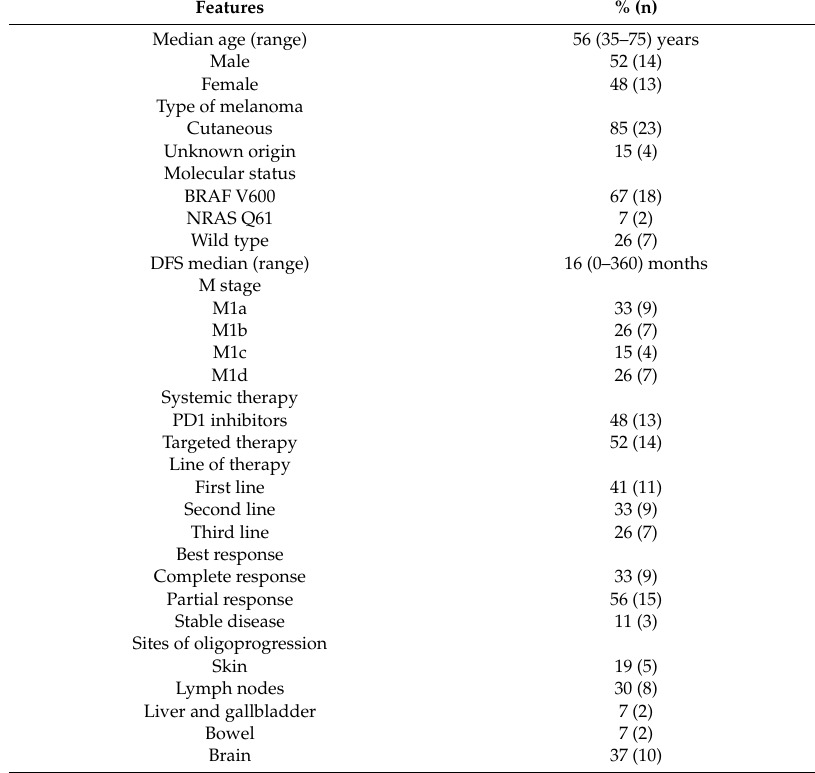
Table 1. Main patient